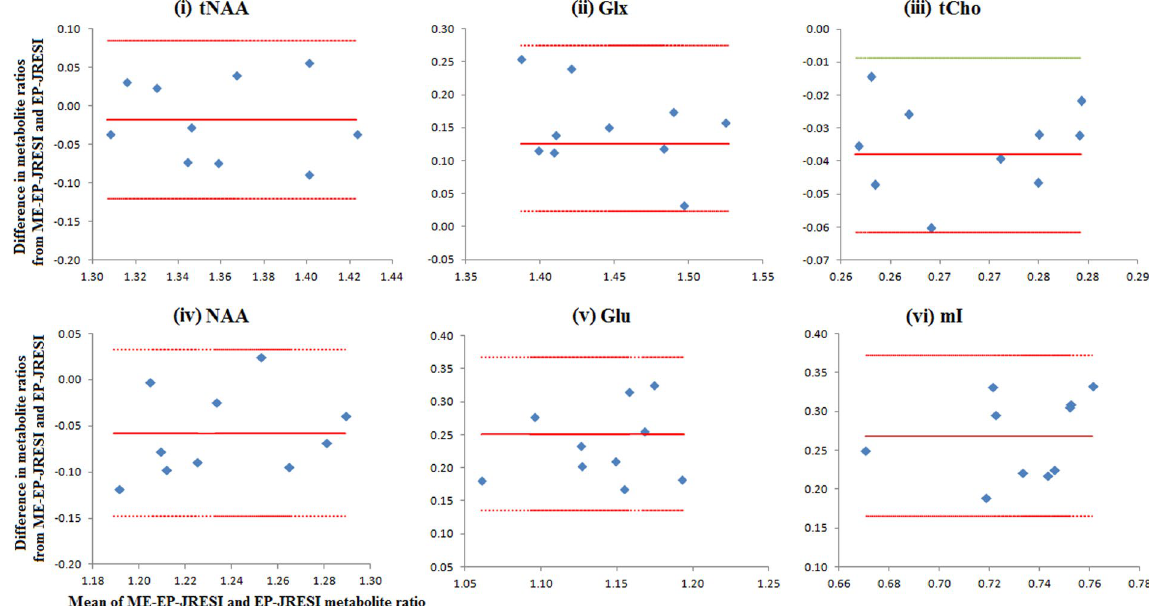
Figure 4. Bland-Altman analysis showing the agreement of phantom metabolite ratios (by ProFit) between the ME-EP-JRESI and EP-JRESI measurements. The red solid lines represent the average difference and the two dashed lines represent lower and upper limits of agreement. All the plots (i–vi) have the same x-axis (Mean of ME-EP-JRESI and EP-JRESI metabolite